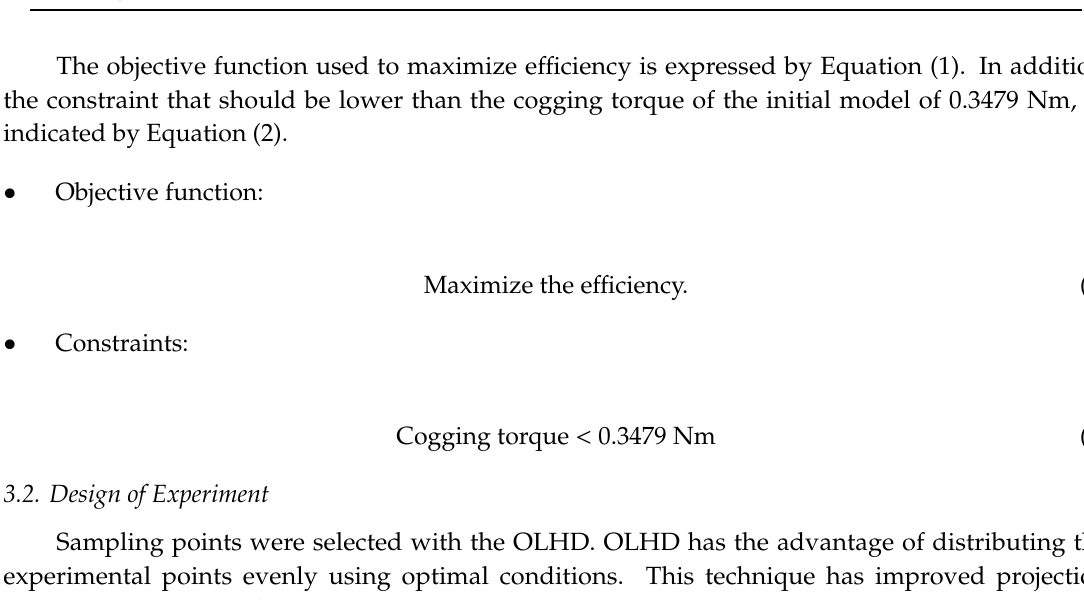
Table 2. Ranges of the design variables